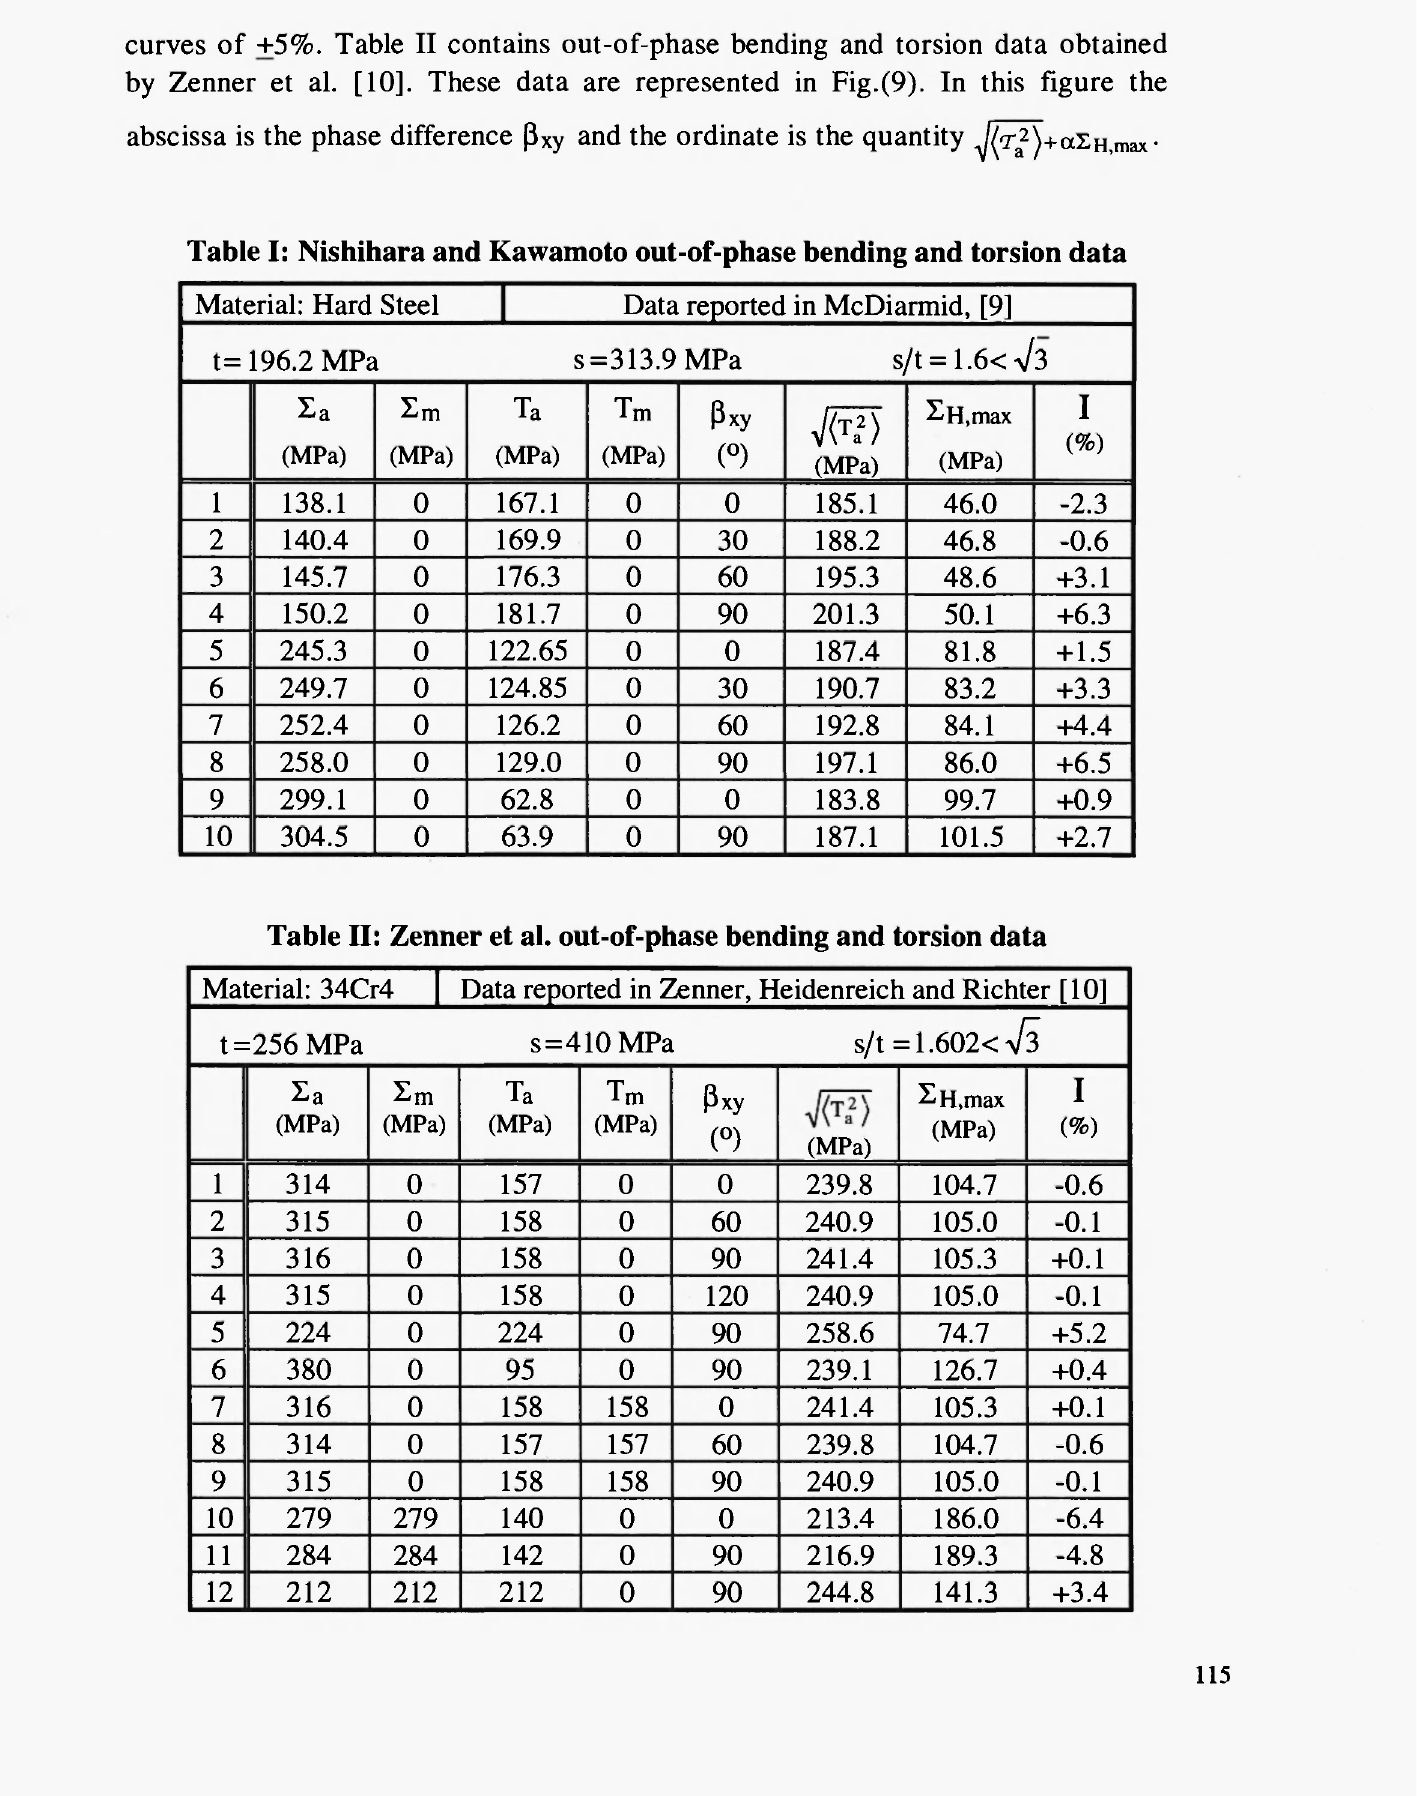
Table II: Zenner et al. out-of-phase bending and torsion data Material: